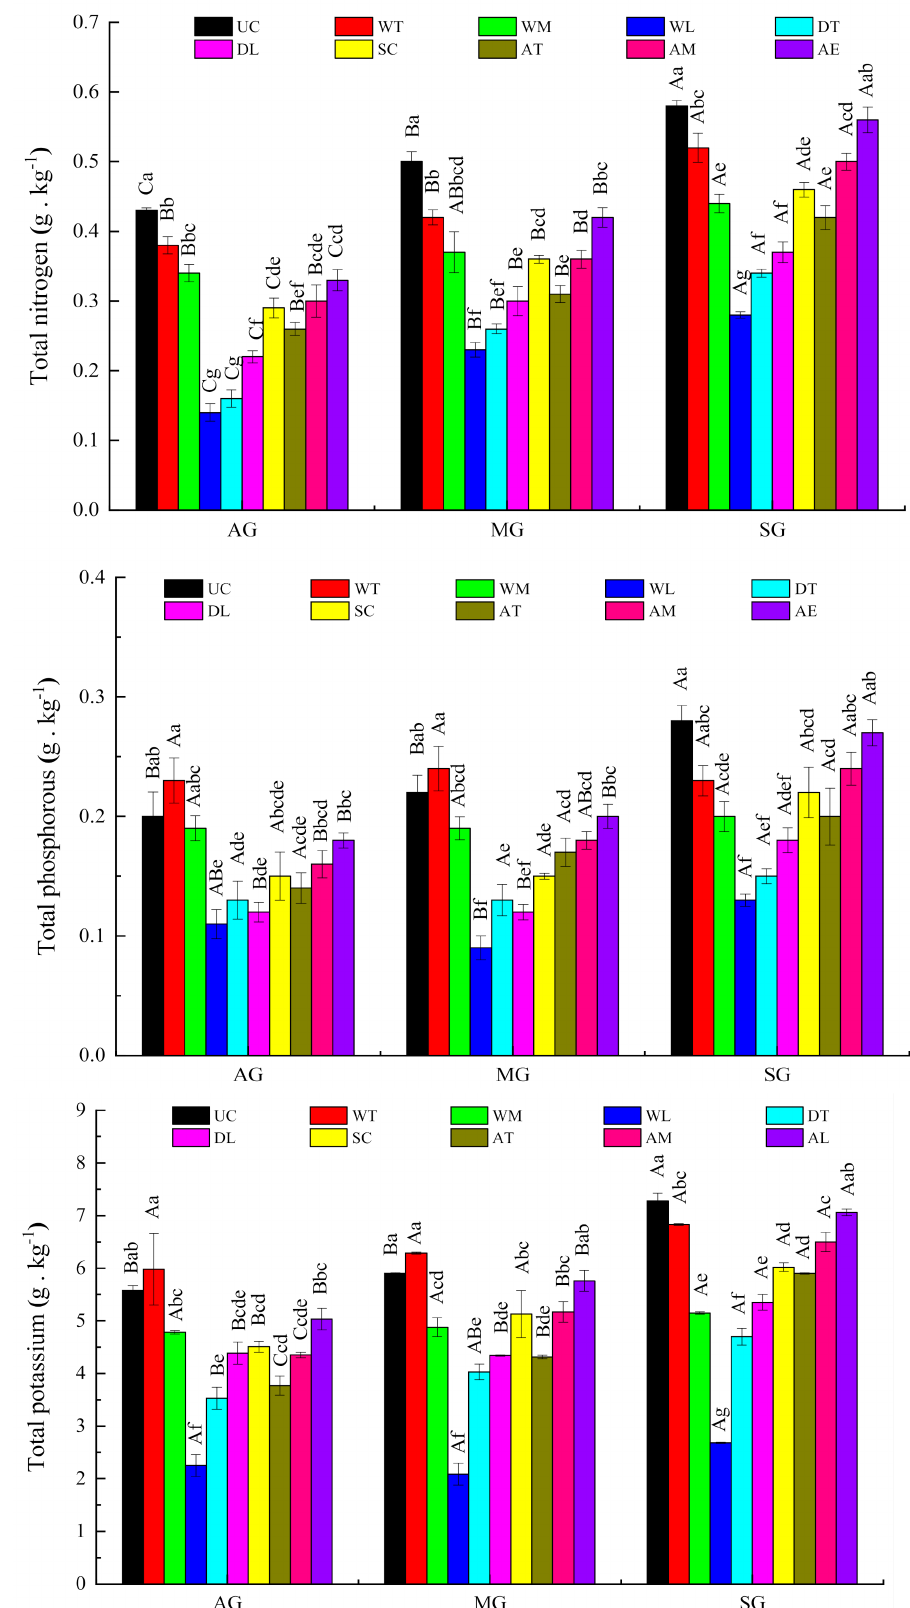
Figure 9. The content of total nitrogen, total phosphorus and total potassium in the different spatial positions in different stages of Benggang